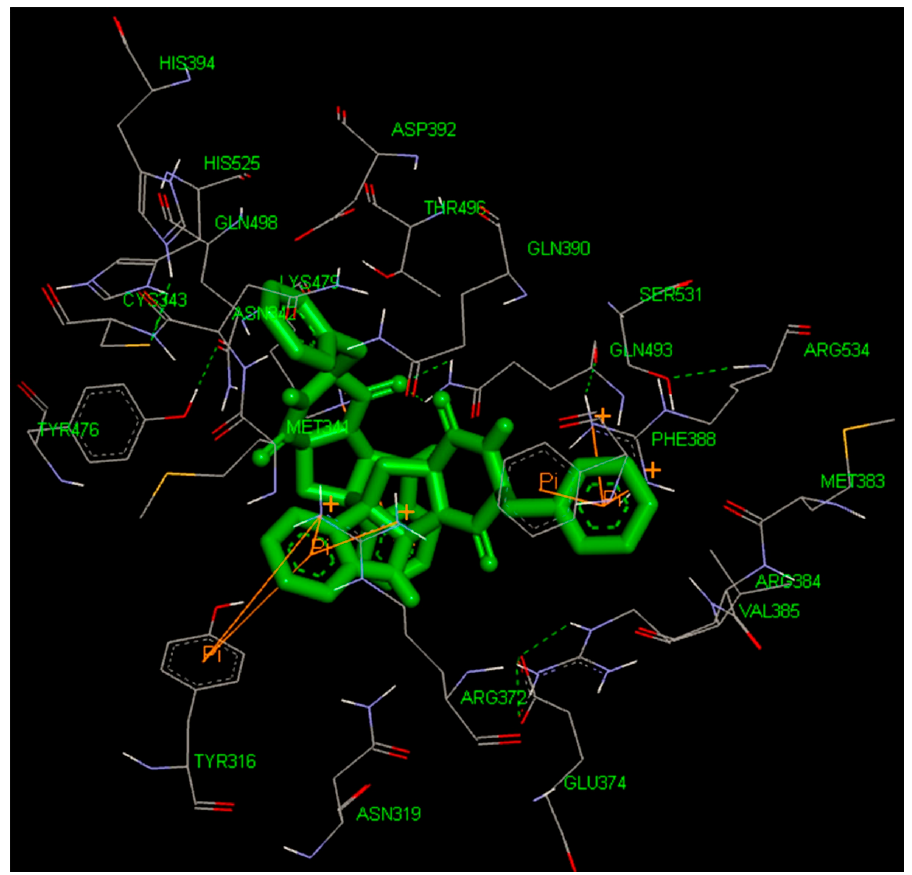
Figure 6. Predicted binding mode of ZINC27215482, as determined by docking of the ligands in the BaThrRS homology model.